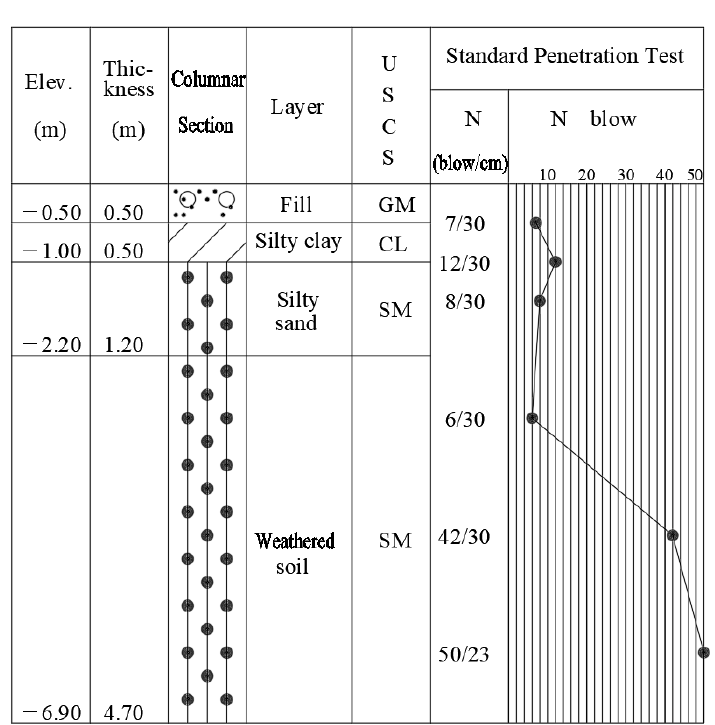
Table 3. Material properties for RSR